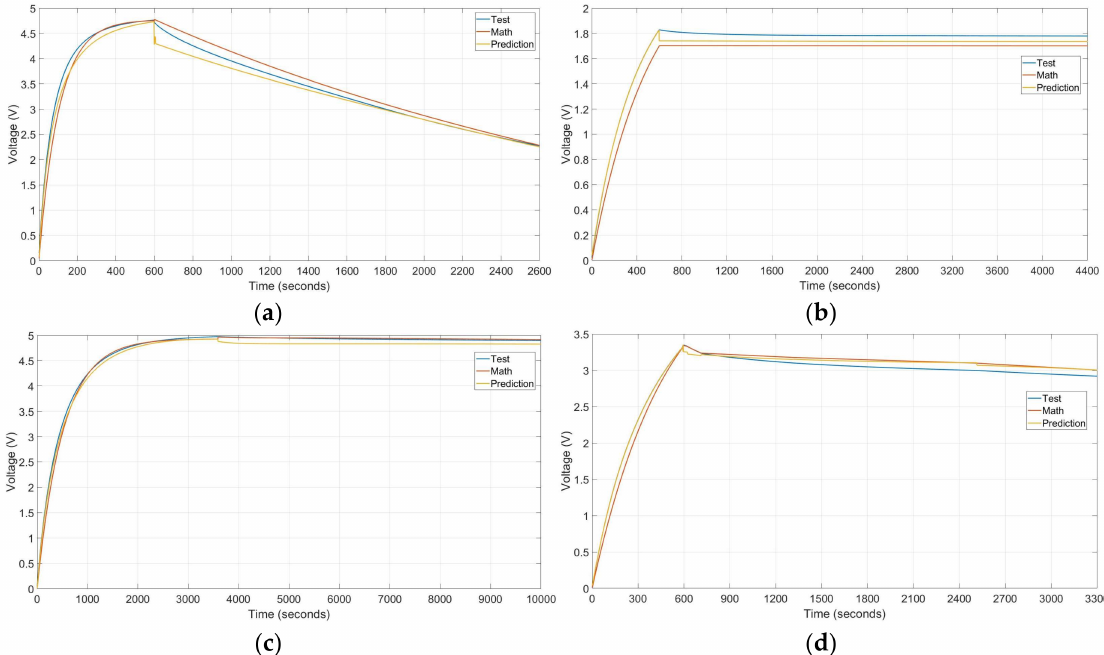
Figure 11. Graphic results and comparisons of described -four different tests. ( a ) 1 Farad supercapacitor charged through 10 min with 5 V at 40 ◦ C and 1 mA consumption discharge, ( b ) 5 Farad supercapacitor charged for 10 min with 2.5 V at 25 ◦ C and self-discharge procedure, ( c ) 1 Farad supercapacitor charge during 1 h with 5 Volt at 10 ◦ C and self-discharge procedure, ( d ) 5-Farad supercapacitor charge through 10 min with 5 V at 40 ◦ C temperature and three discharge steps: 0.3 mA consumption through 3 min, 0.1 mA consumption through 10 min and